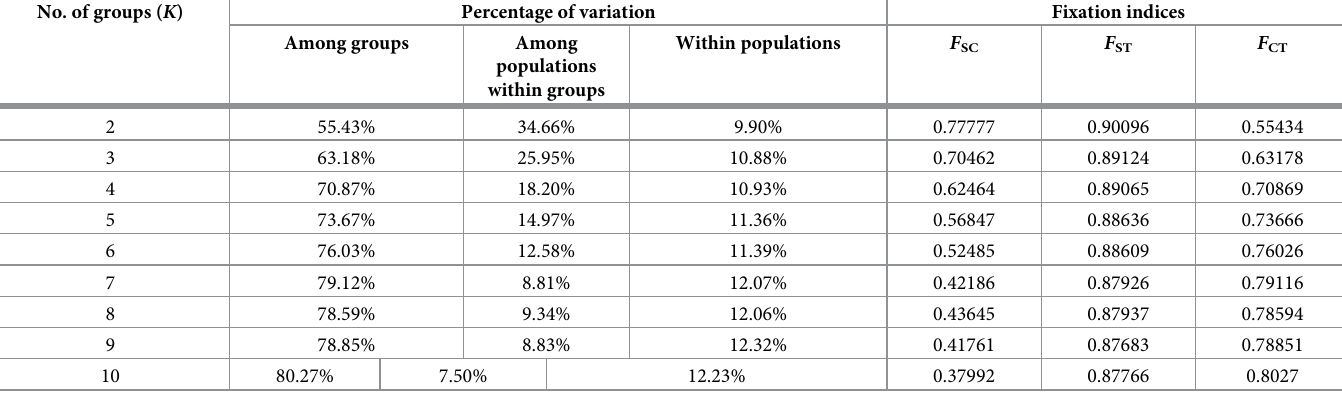
F SC : Proportion of genetic variation between populations within groups. F ST : Proportion of genetic variation between populations and groups overall. F CT : Proportion of genetic variation among